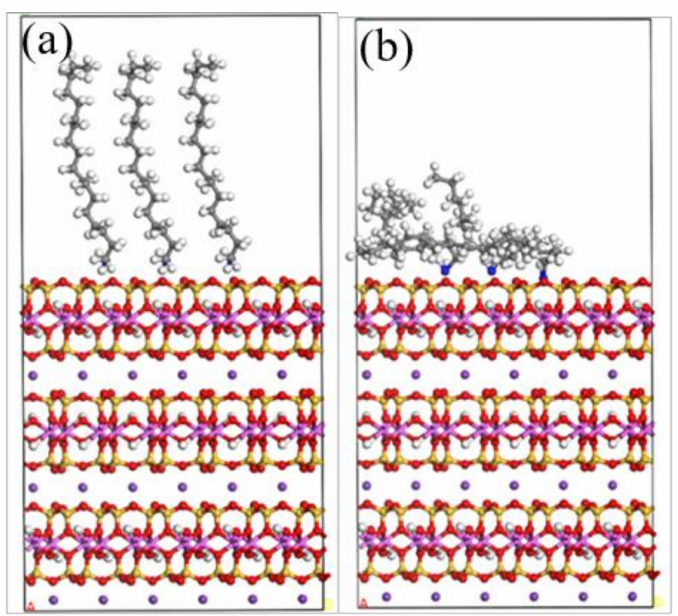
Figure 11. Changes in ODA before and after adsorption on the muscovite (002) crystal plane (( a ) pre-adsorption and ( b ) post-adsorption).